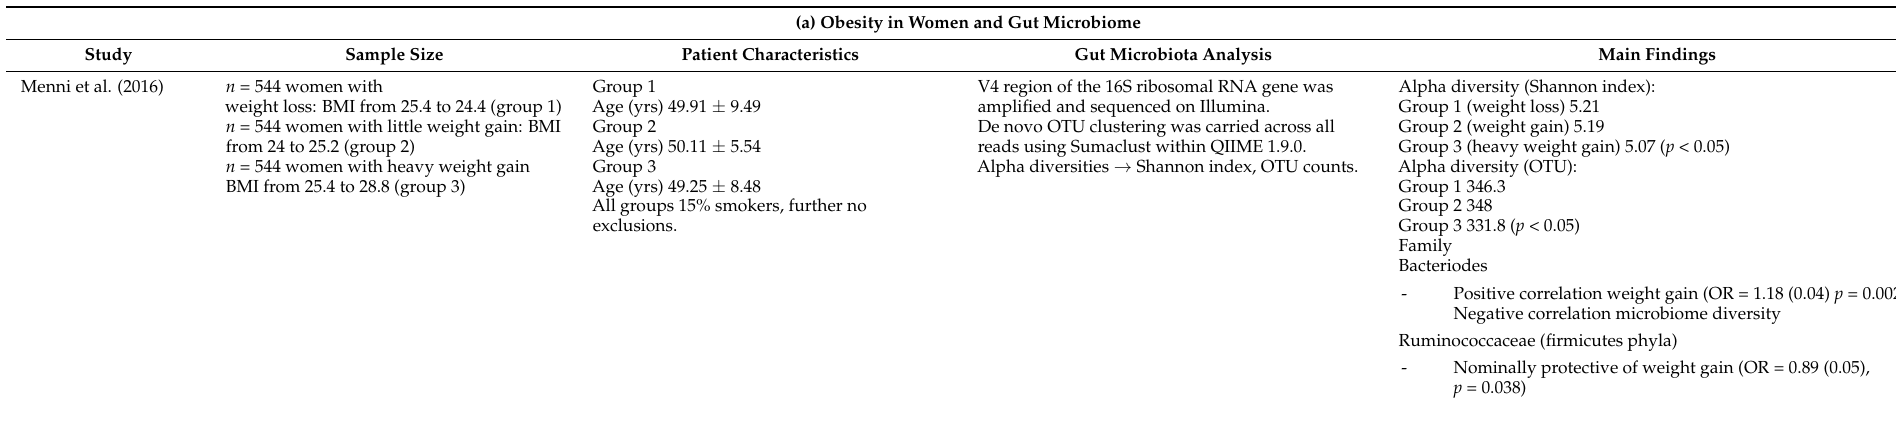
Table 2. Characteristics and summary, of studies included for research question